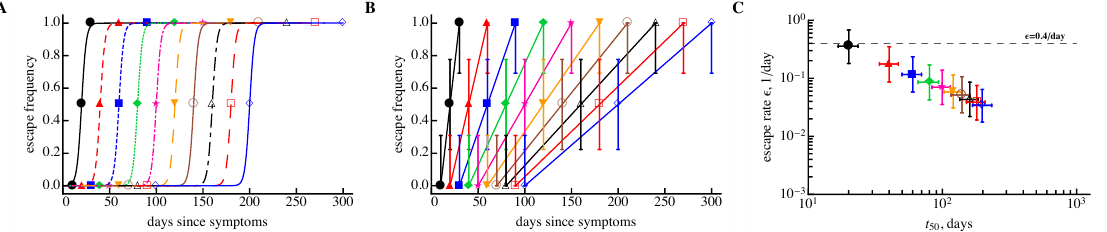
Figure 4. Time interval between measurements has a strong bias on the estimate of the escape rate and leads to a correlation between the escape rate ( ε ) and time of escape ( t 50 ). We generated artificial data in which viral sequences were measured in three time points, resulting in 0%, 50%, and 100% of the escape variant with N = 10 sequences per time point (panel A ). In all cases, escape can be described by the logistic equation (Equation (1)) assuming a delayed immune response and escape rate ε = 0.4/day. We resampled these simulated “data” using a beta distribution (panel B , different lines indicate different escapes as in panel A ) and estimated the average escape rate (panel C ). We show the prediction of the logistic curve obtained using ε = 0.4/day (panel A ), sampled data (panel B ), and estimates of the escape rate obtained using parametric bootstrap (panel C ). The horizontal dashed line in (panel C ) denotes the theoretical escape rate of 0.4/day. The 95% confidence intervals in (panel B ) are predicted using Jeffrey’s intervals [33], and in (panel C ) CIs were calculated from bootstrapped